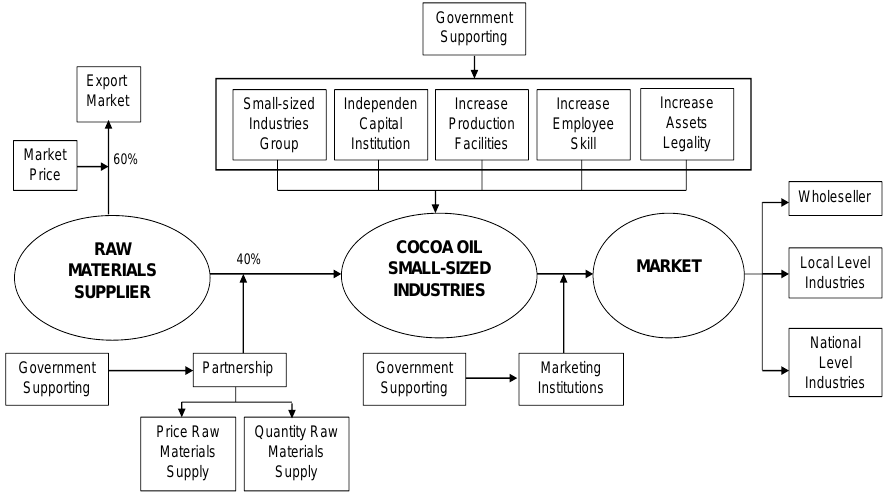
Figure 2: Empowerment Model of Cocoa Oil Small-sized